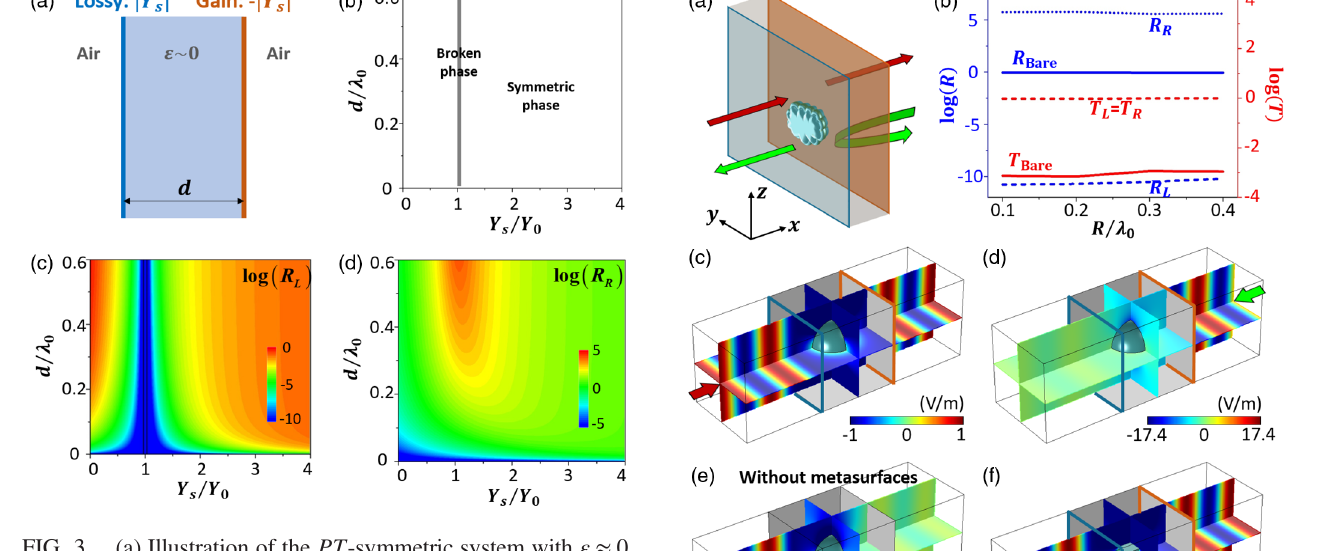
FIG. 3. (a) Illustration of the PT -symmetric system with ε ≈ 0 . (b)Phasediagramfornormalincidence.Thewhiteandgrayregions denote the symmetric phase and broken phase, respectively. [(c) and (d)] Reflectance as the functions of d= λ 0 and Y s =Y 0 for (c) left and (d) right incidence on the PT -symmetric system.